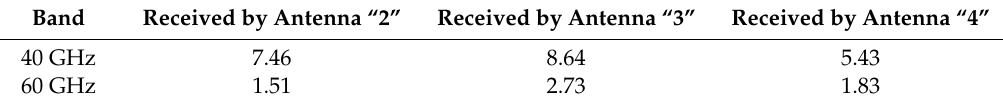
Table 1. RMS delay spread stays below this value (ns) 99% of the time, in the auditorium.